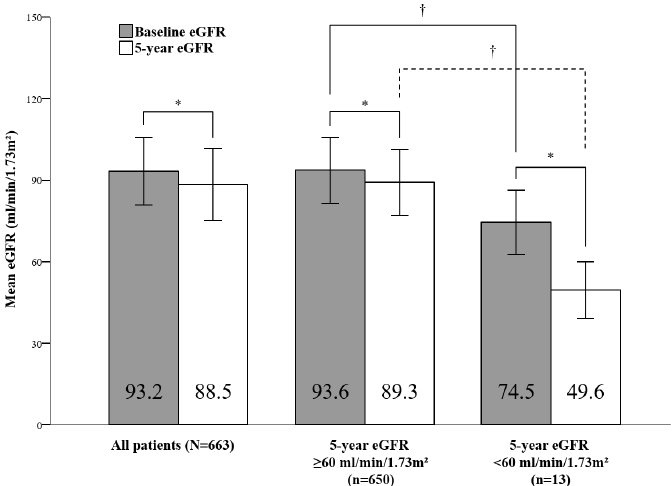
Figure 2. Comparison of baseline and five-year estimated glomerular filtration rates; eGFR, estimated glomerular filtration rate. * Paired t -test, p < 0.001; † independent-sample t -test, p < 0.001.